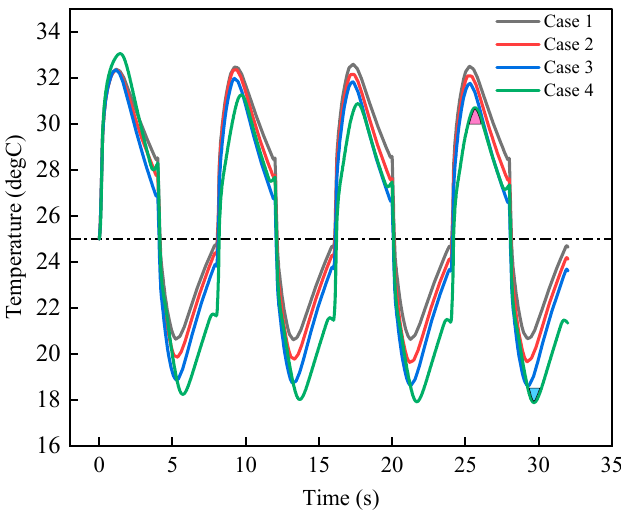
Figure 10. Temperature variation of fl uid under di ff erent temperature spans. It is known that only the EC device was simulated in COMSOL Multiphysics. Figure 9 shows that only in Case 1 does the fl uid that fi nishes the cycle end up with a temperature close to the original temperature of the EC device, which demonstrates that Case 1 is the most ideal cycle among the four cycles. Figure 11 shows the temperature contour of the center plane of the EC heat pump in a complete cycle at Case 1. Among them, 1.18 s and 5.34 s are the highest and lowest moments of the fl uid domain’s temperature in the cycle, respectively. The temperature on the left side of the EC material dropped more than that on the right side, and the temperature of the EC material in the middle position dropped more than that on the upper and lower sides after the end of the fi rst half of the cycle. When it comes to the second half of the cycle, the same situation of temperature inhomo- geneity happens again. For the layered EC heat pump device, the temperature imbalance between left and right is normal, but the temperature imbalance between upper and lower should be minimized to utilize the heat production and cooling capacity of the EC material most e ff ectively. Therefore, increasing the number of layers of EC material is expected to ensure su ffi cient heat transfer between fl uid and EC material. Hence a four-layer EC heat pump is further simulated at the same operating conditions of Case 1.